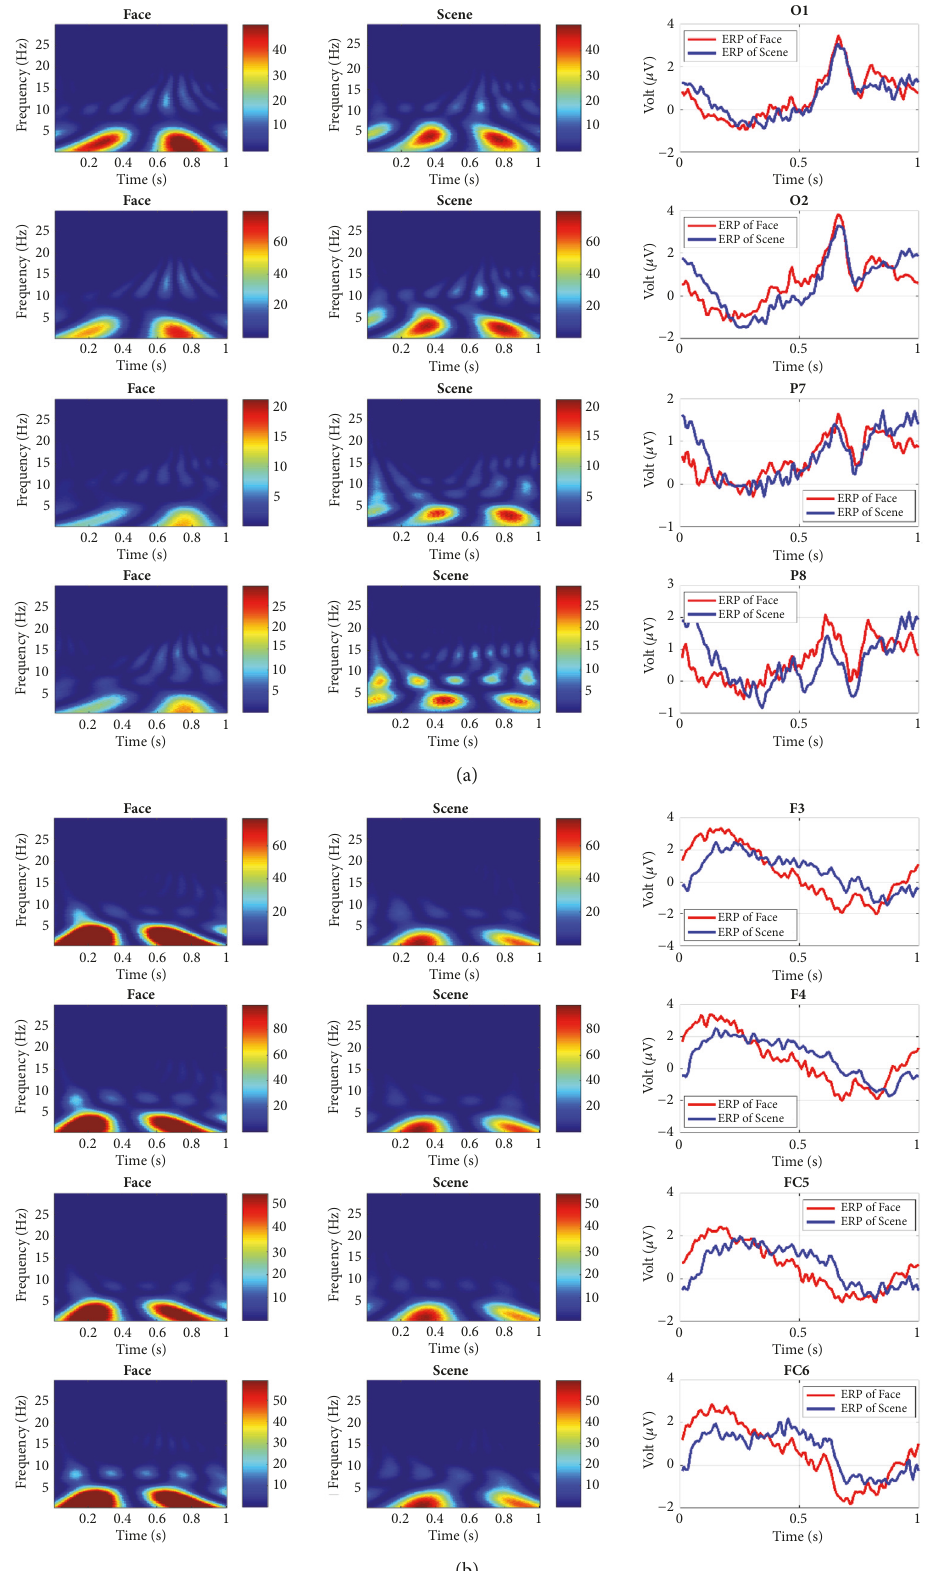
Figure 4: Time-frequency (left and middle) and averaged ERP responses (right) from all participants at (a) visual and parietal sites (O1, O2, P7, and P8), electrode sites; (b) frontal sites (F3, F4, FC5, and